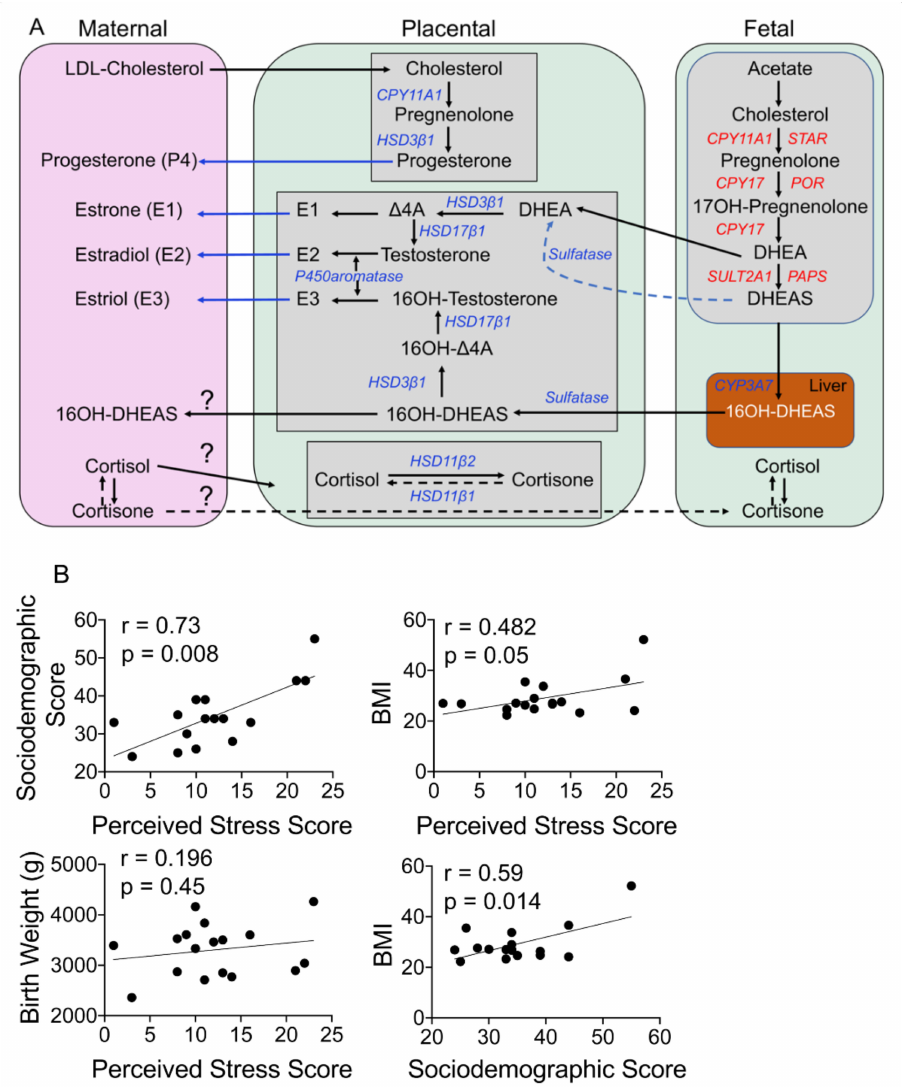
Figure 1. ( A ) Schematic of steroidogenesis in maternal–fetal compartments during pregnancy. Maternal cholesterol is transported to the placenta, where it serves as a precursor for the production of progesterone and its metabolites. Maternal glucocorticoids can be transported to the placenta and across to the fetal circulation. The fetus makes its own cholesterol from acetate and converts it to DHEAS via several steps, as shown. DHEAS is transported to the fetal liver and from there to the placenta, where DHEAS is converted to testosterone and ultimately to estrogens (estrone (E1), estradiol (E2), and estriol (E3)), which are subsequently transported to the maternal circulation from the placenta. Abbreviations: LDL-cholesterol: low-density lipid cholesterol; CYP11A1: cytochrome P450 family 11 subfamily A member 1; CYP17: cytochrome P450 17; CYP3A7: cytochrome P450 family 3 subfamily A member 7; ∆ 4A: delta 4 androstenedione; DHEA: dehydroepiandrosterone, DHEAS: dehydroepiandrosterone sulfate; HSD3 β 1: hydroxysteroid dehydrogenase 3-beta isomerase 1; HSD17 β 1: hydroxysteroid 17-beta dehydrogenase 1; HSD11 β 1: hydroxysteroid 11-beta dehydrogenase 1; HSD11 β 2: hydroxysteroid 11-beta dehydrogenase 2; PAPS: 3 (cid:48) -phospho-5 (cid:48) -adenylyl sulfate; POR: P450 oxidoreductase; STAR: steroidogenic acute regulatory protein; SULT2A1: sulfotransferase family 2A member 1. ( B ) Maternal stress associates with her health outcomes but does not affect the baby’s birth weight. Linear regression analysis revealed that the maternal perceived stress score (PSS) correlates positively with her sociodemographic score ( r = 0.73, p = 0.0008) and body mass index (BMI) ( r = 0.48, p = 0.05) but not the infant’s birth weight. The mother’s sociodemographic score positively correlates with her BMI ( r = 0.59, p = 0.014). N =